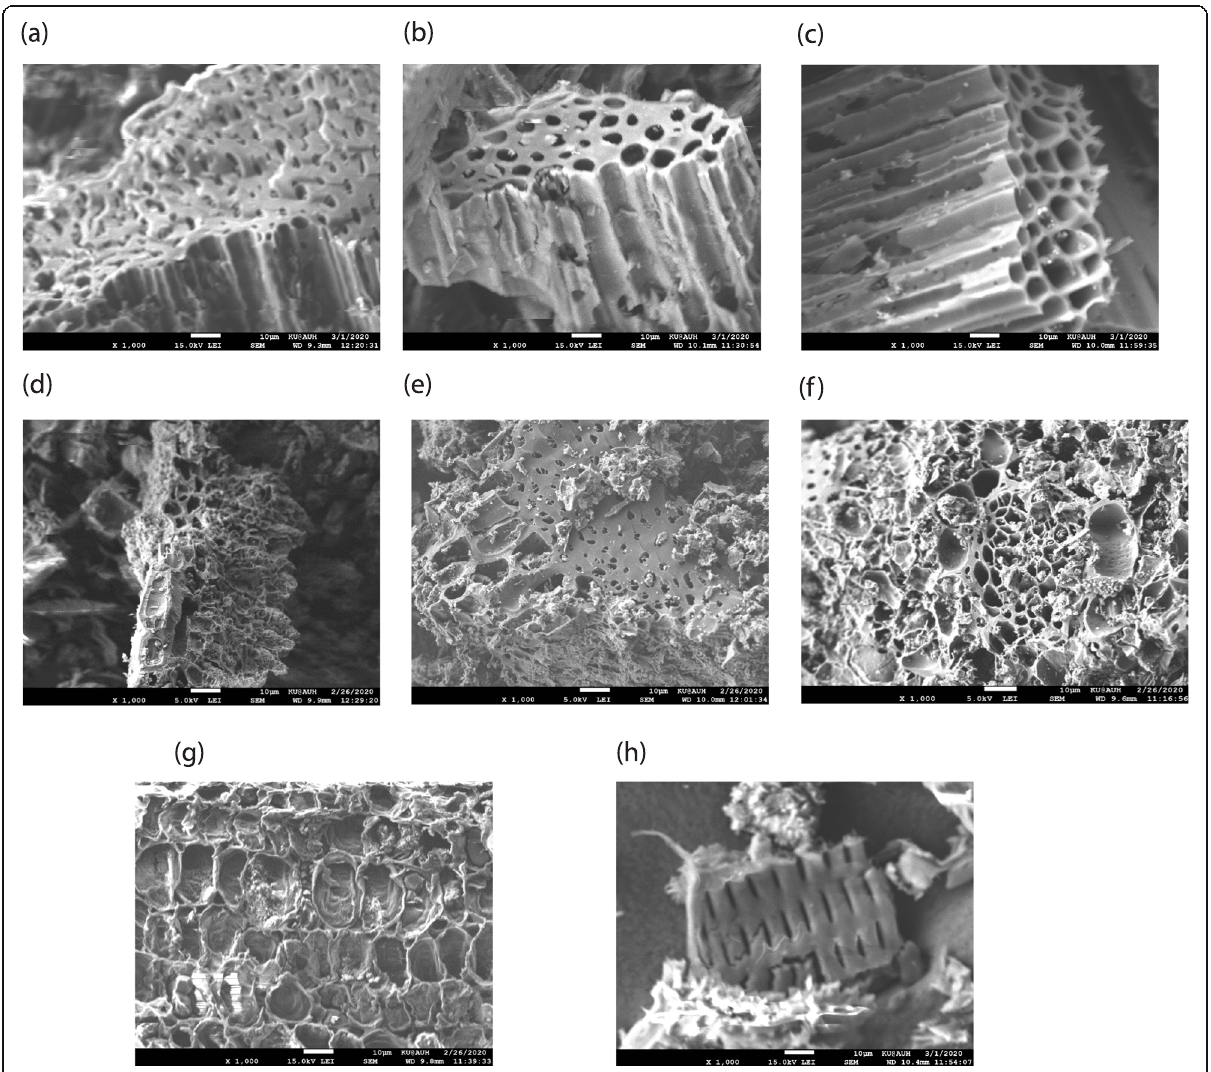
Fig. 2 SEM images of a Frond 400, b Frond 500, c Frond 600, d Leaf 400, e Leaf 500, f Leaf 600, g Leaf feedstock h Frond feedstock